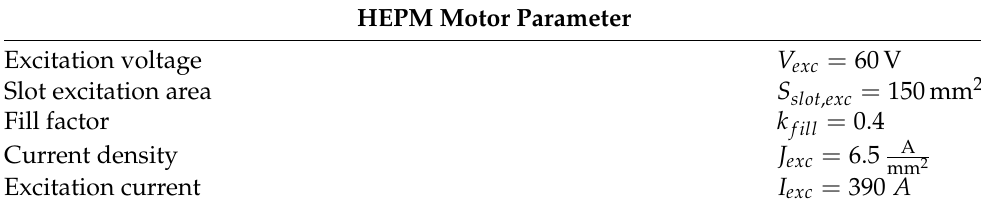
Table 3. HEPM Motor Excitation Geometry.